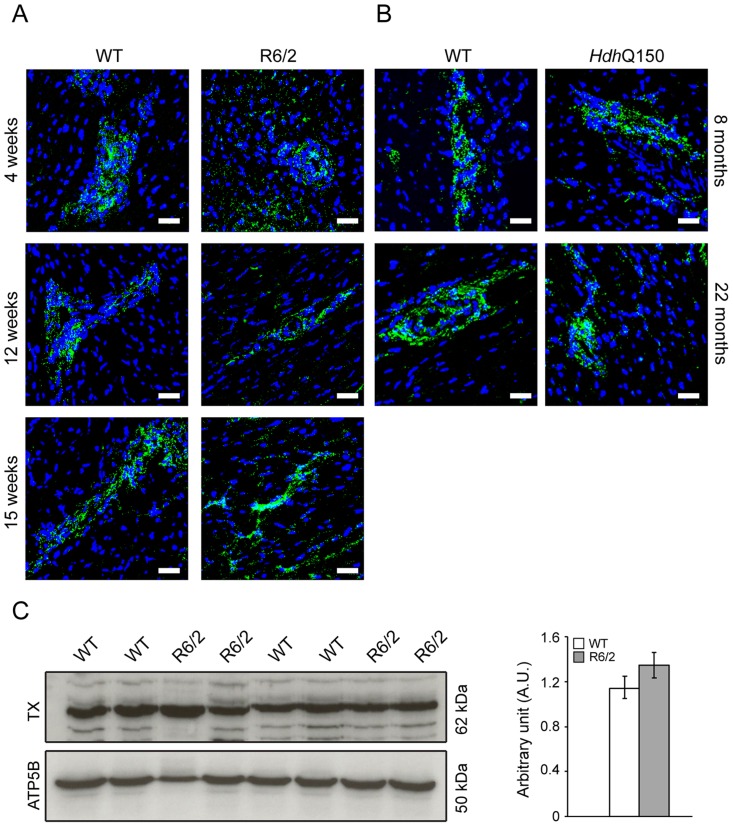
Architecture of altered ganglionic plexuses based on tyrosine hydroxylase localisation in HD mouse model hearts.Representative confocal pictograms of whole heart sections from (A) 4, 12 and 15 week old of R6/2 mice and (B) 8 and 22 month old HdhQ150 mice. Anti-tyrosine hydroxylase antibody (green) was used to mark ganglionic plexuses and nuclei (blue) were visualised with DAPI. Scale bar 30 μm. (C) Western blots of tyrosine hydroxylase in 15-week-old WT and R6/2 mice. Relative expression of tyrosine hydroxylase was normalised to ATP5b by densitometry and values are mean ± SEM (n = 4). Student's t test: *p<0.05, **p<0.01, ***p<0.001.